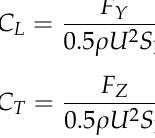
Figure 7. A comparison of the instantaneous lift and thrust coefficients of the wing in the hovering motion between coarse, medium, fine and finer grids ( a ) four kinds of lift force coefficient curves, C L , in comparison; ( b ) four kinds of thrust coefficient curves ,C T , in comparison.